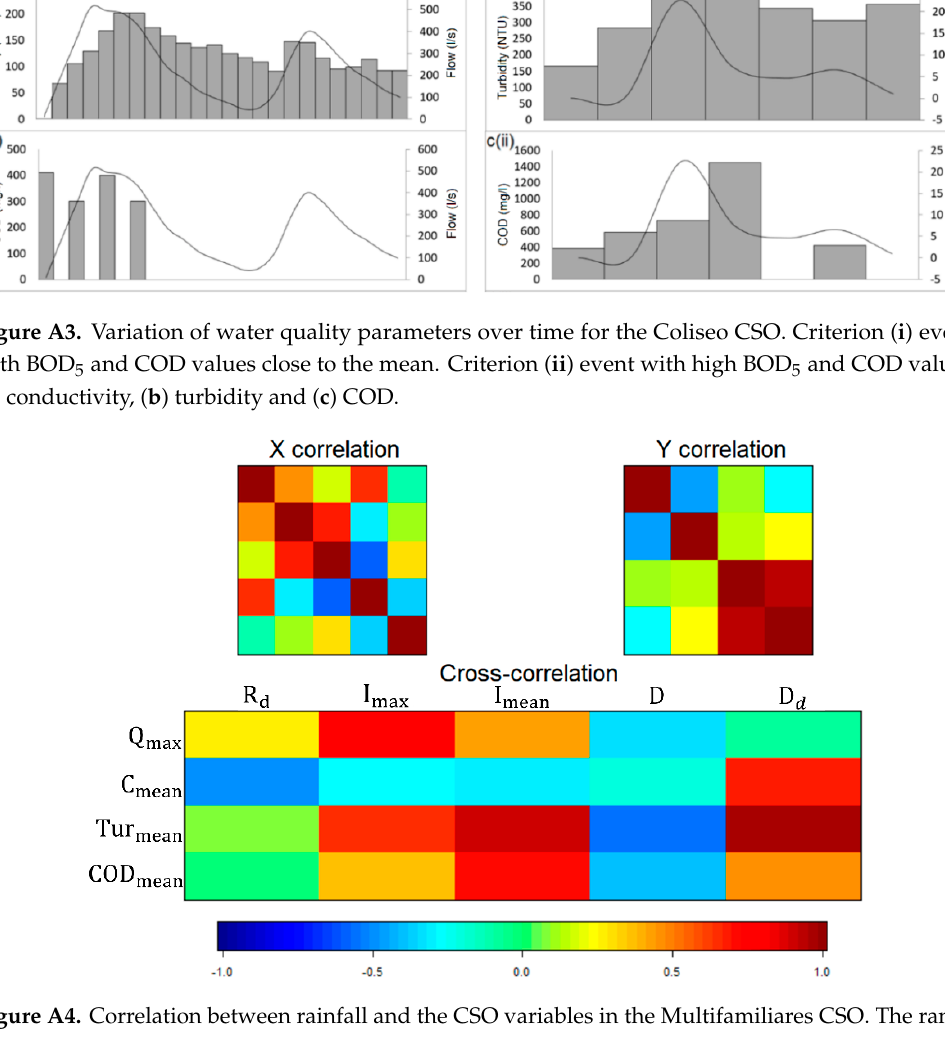
of colors indicates the degree of correlation according to the graphic’s scale. The colors close to brown